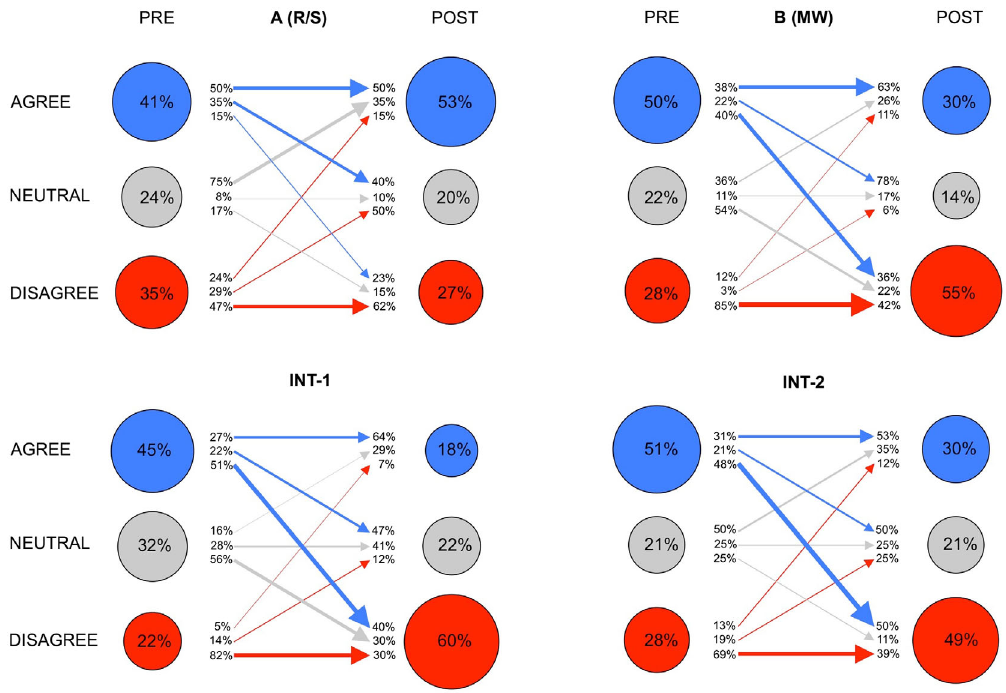
FIG. 10. Pre- and postinstruction responses from four modern physics courses (as described in the text) to the statement: The probabilistic nature of quantum mechanics is mostly due to the limitations of our measurement instruments. N ¼ 49 ( A ), 126 ( B ), 77 (INT-1), and 57